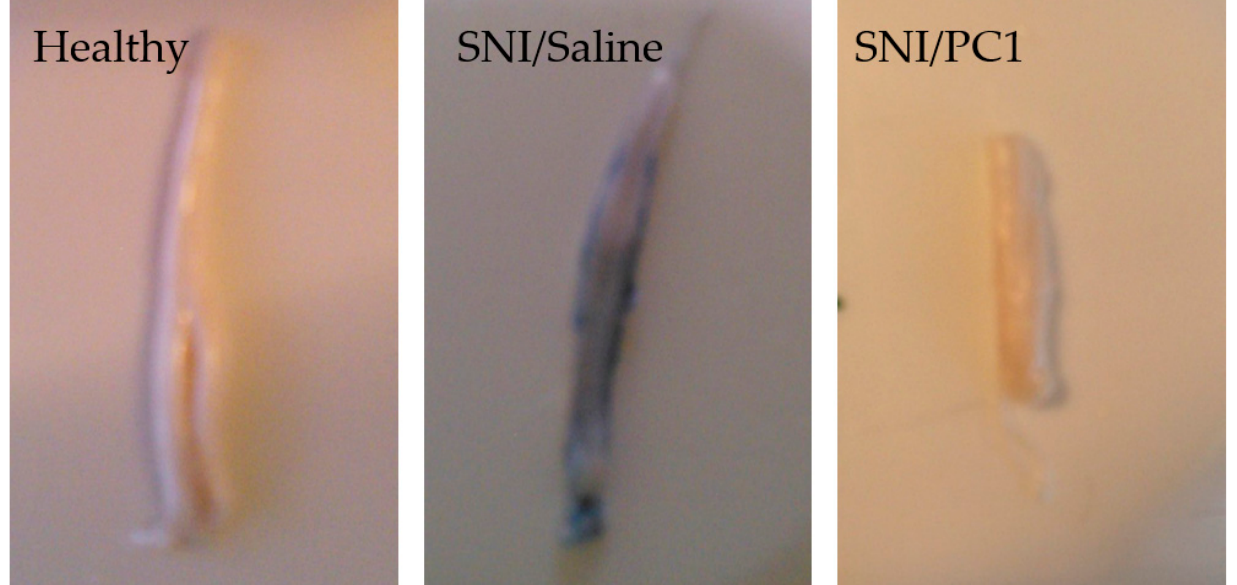
Figure 1. Increased blood–spinal cord barrier permeability (BSCB) after spinal nerve ligation (SNI) in mice. Lumbar spinal cord images of healthy mice compared to injured mice treated with saline or with PC1 (150 µg/kg sc, twice a day). In this Blue Evans assay exudation is evident in the spinal cord of SNI mice but PC1 is able to reduce it already after two days of treatment.